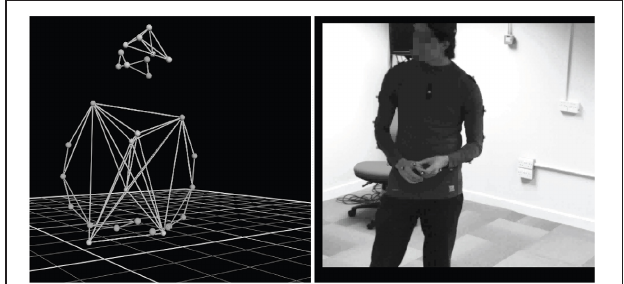
FIGURE 4 | Marker placement for body, head, and face, reconstructed with an accuracy of 0.1mm using Vicon Nexus motion tracking